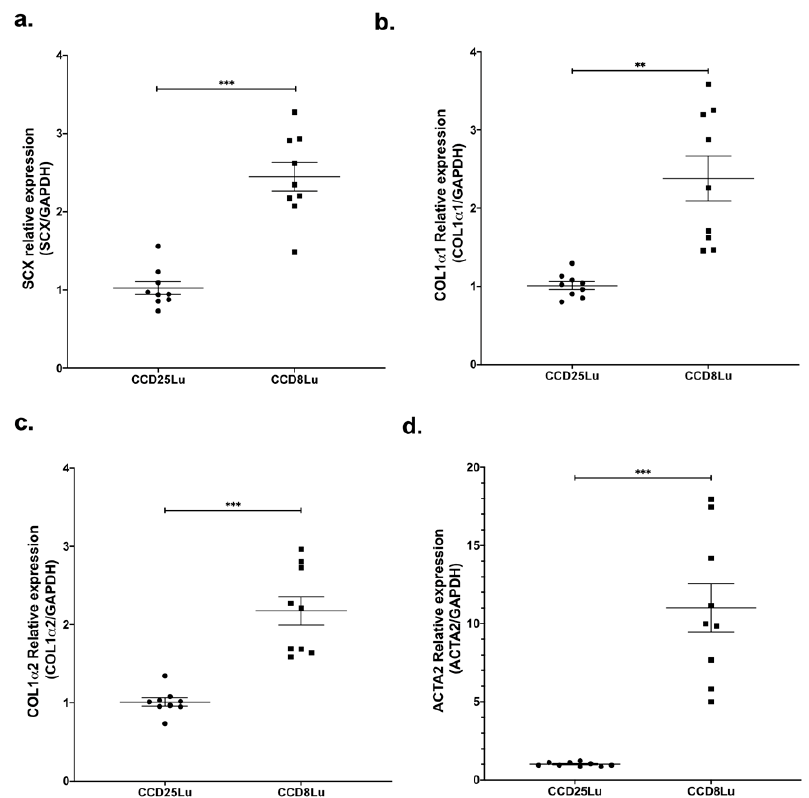
Figure 1. SCX expression levels in lung fibroblasts correlated with the expression of profibrotic genes. Expression of genes SCX ( a ), COL1A1 ( b ), COL1A2 ( c ), and α -SMA/ACTA2 ( d ) in pulmonary fibroblasts CCD25Lu and CCD8Lu. (a) Scleraxis expression was measured by qPCR using Taqman Hs03054634_g1 relative to GAPDH (Hs02786624_g1). Panels (b–d) correspond to COL1A1 (Hs00164004_m1), COL1A2 (Hs01028956_m1), and α -SMA/ACTA2 (Hs00426835_g1) expression relative to GAPDH, respectively. Statistical differences were assessed using the Student’s t-test. ** = p < 0.01, *** = p < 0.001.